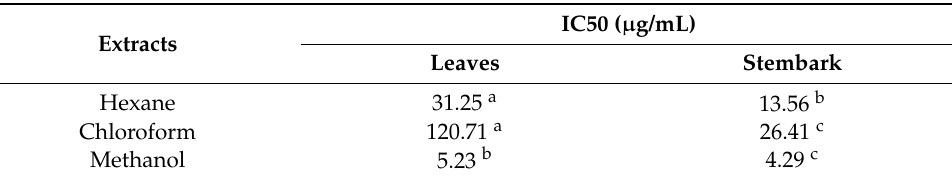
Table 1. DPPH free radical scavenging activities (IC50 values) of the leaf and stembark extracts (hexane, chloroform, and methanol) of C. erythrophyllum (a–c indicate significantly different data.